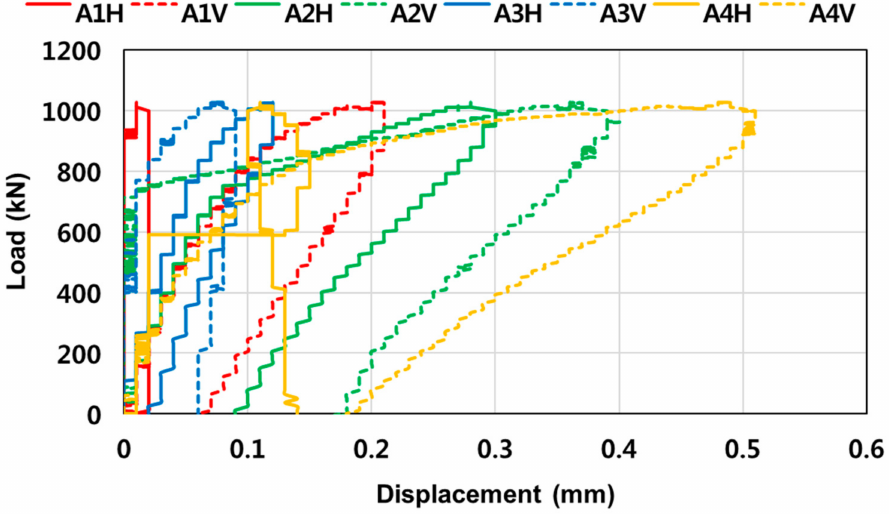
Figure 8. Anchorage displacement.